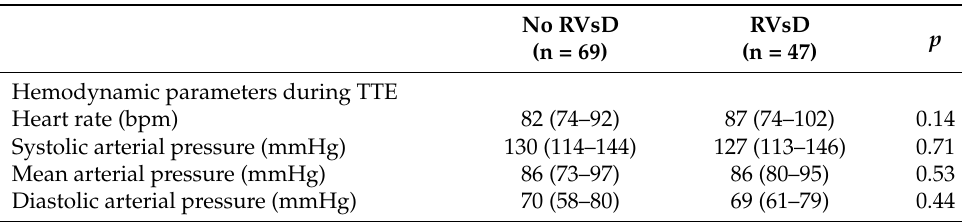
Table 2. Hemodynamics, TEE parameters and